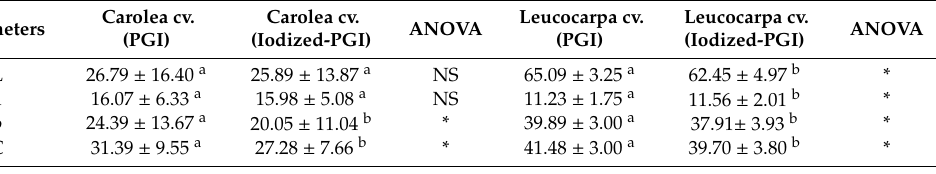
Table 4. Change in color values of processed olives. NS = not significant; * = significant. Significant di ff erences are indicated by di ff erent letters ( P < 0.05). Figure 5. CA dendrogram of data-set based on mineral composition. Dendrogram is obtained using the Ward’s algorithm and the Euclidean distance similarity. CAR_fresh: Carolea fresh, LEU_fresh: Leucocarpa fresh; CAR_PGI: Carolea fermented in PGI sea salt; LEU_PGI: Leucocarpa fermented in PGI sea salt; CAR_PGI_I: Carolea fermented in iodized PGI sea salt; LEU_PGI_I: Leucocarpa fermented in iodized PGI sea salt.